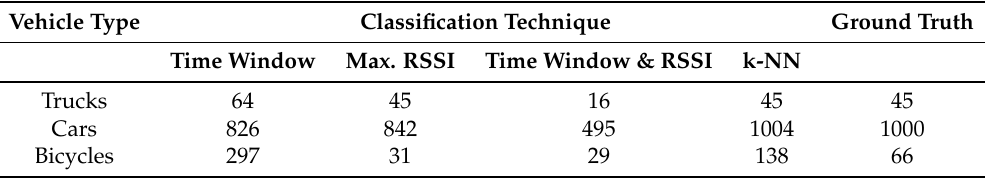
Table 5. Number of vehicles detected by the algorithm, according to vehicle type and classification technique for Steinfurter